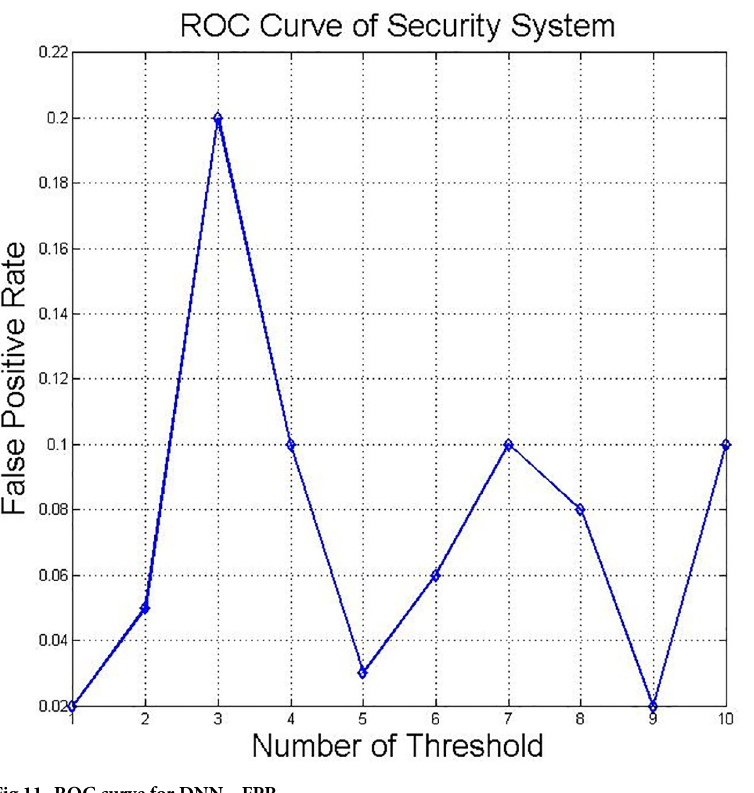
Fig 11. ROC curve for